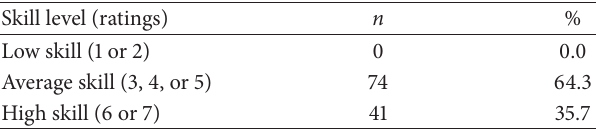
Table 4: Self-perceived level of political skill ( 𝑁 = 115